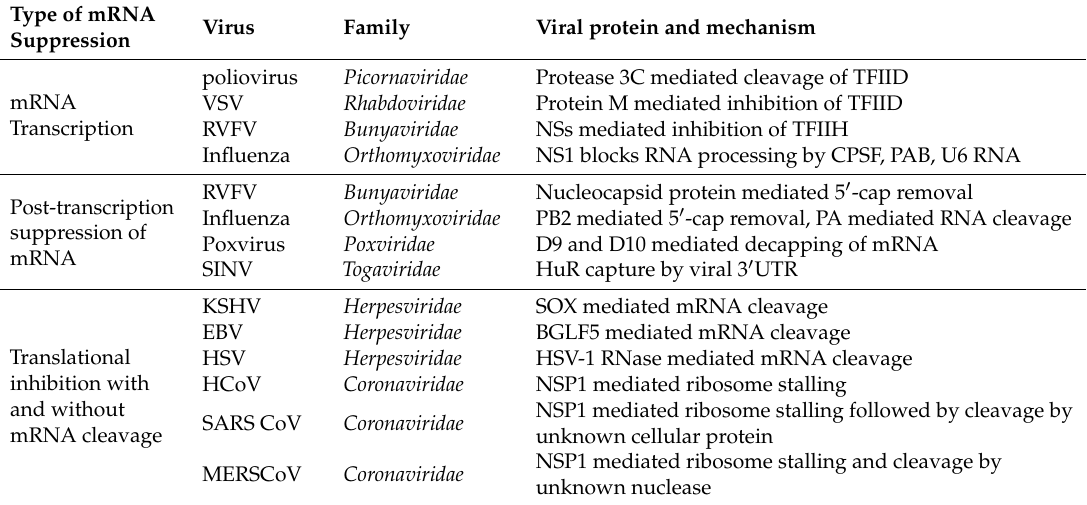
Table 2. Summary of mRNA suppression